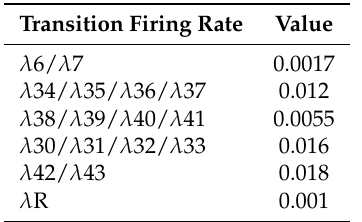
Table 5. Transition firing rate of timed